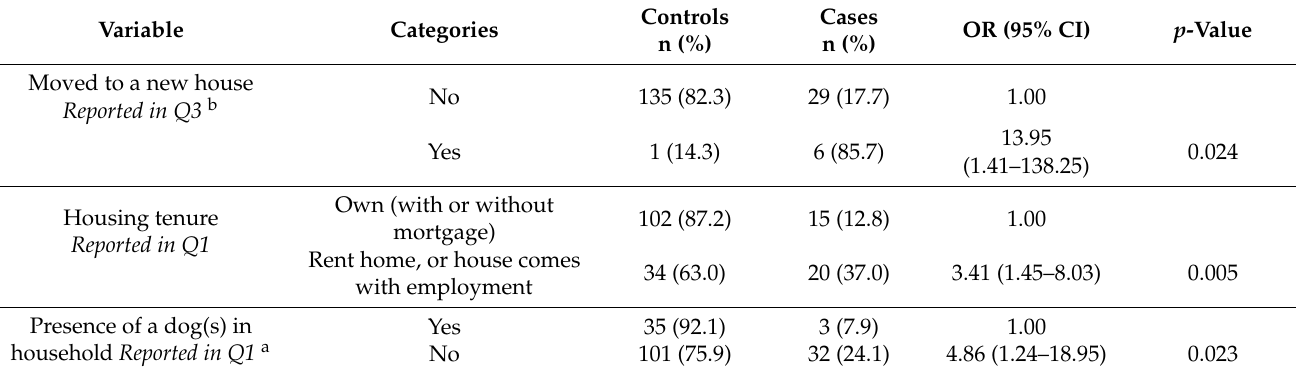
Table 5. Multivariable logistic regression model summarising explanatory variables that were associated with chronic pica. Variable